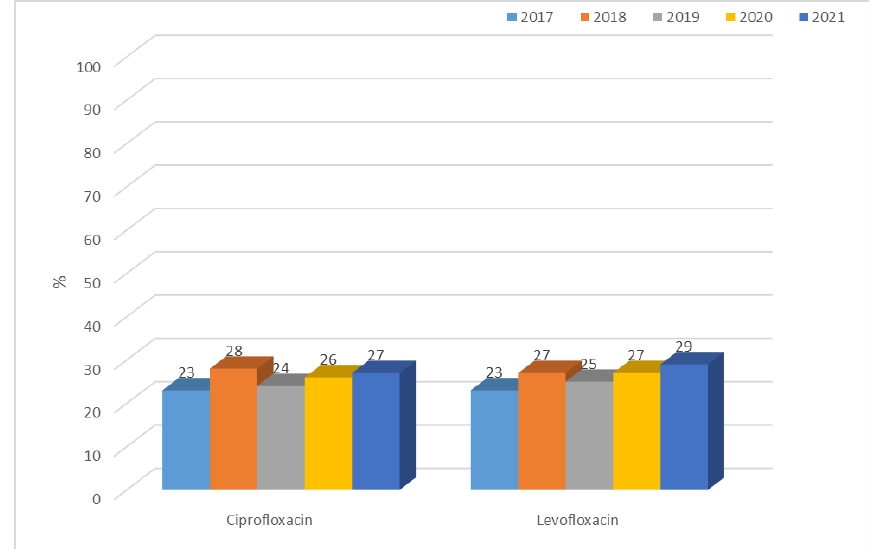
Figure 21. Percentage of K. pneumoniae ESBL(−) strains resistant to quinolones.